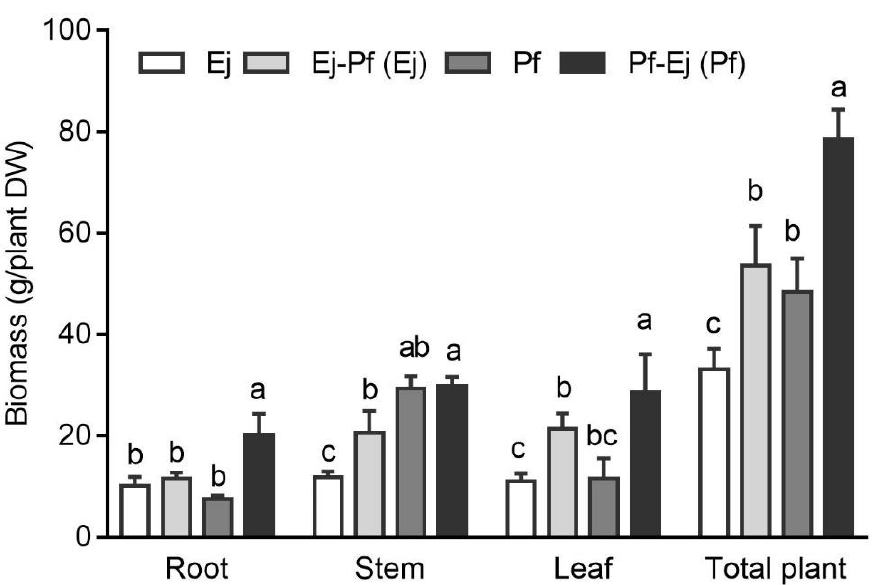
Figure 1. Biomass of P. × fraseri and E. japonicus in the monoculture and intercropping systems. Ej and Pf refer to E. japonicus and P. × fraseri in the monoculture system, respectively; Ej-Pf and Pf-Ej (Pf) refer to E. japonicus and P. × fraseri in the intercropping system, respectively. All values are presented as the mean ± standard error ( n = 4), and bars with different lowercase letters indicate significant ( p < 0.05) differences between the treatments and control, according to Duncan’s test.